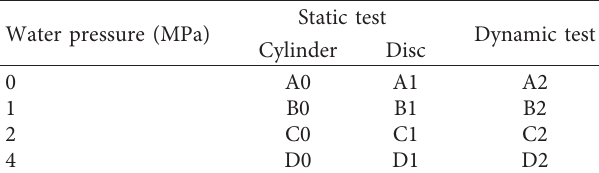
Table 2: Group numbers of